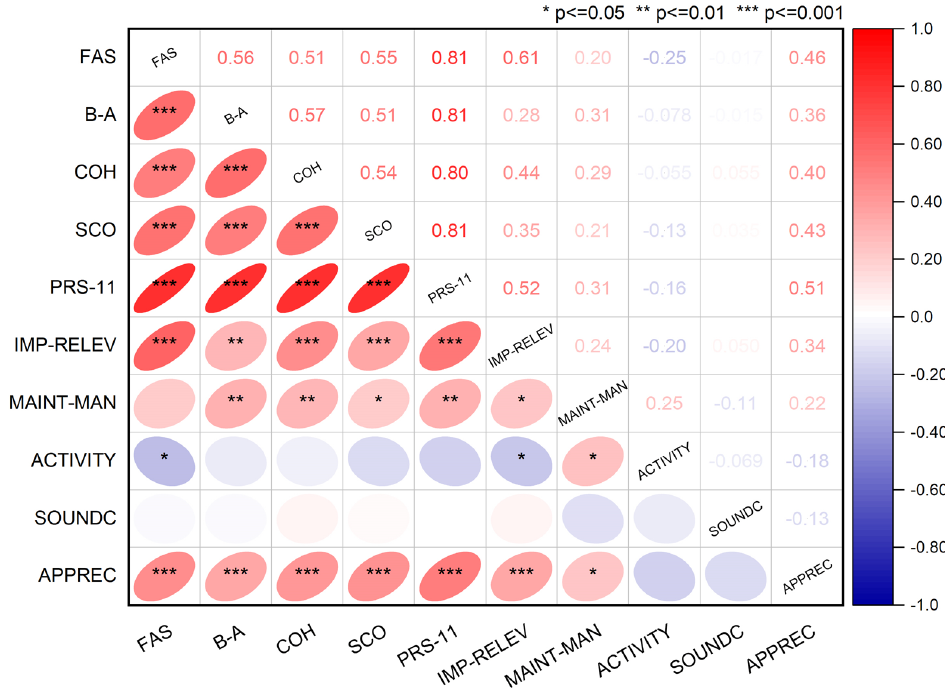
Figure 6: Pearson correlation matrix between the five macro-aspects, Perceived Restorativeness Scale (PRS-11) and its components: Fasci- nation (FAS); Being-Away (B-A); Coherence (COH) and Scope (SCO)